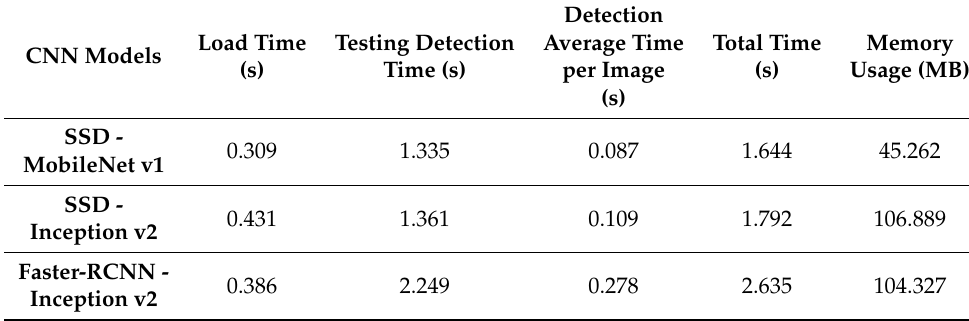
Table 5. Experimental Scenario I, x64, 24-core CPU detection time and memory usage.